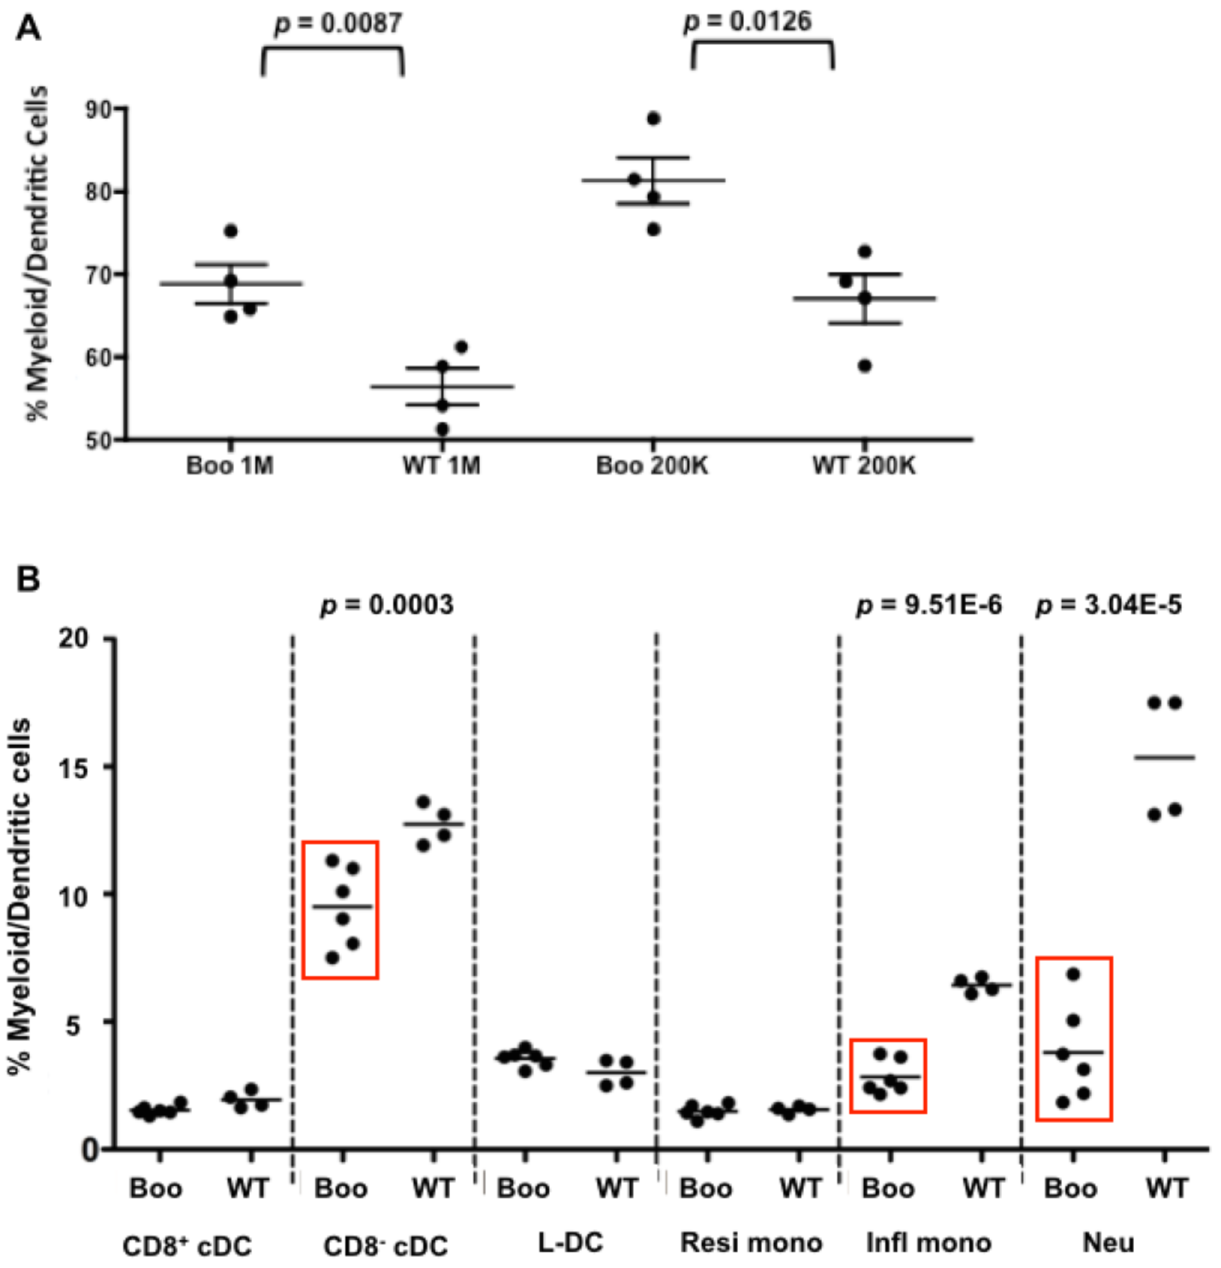
Fig 6. Analysis of splenic myeloid and DC subsets in booreana versus WT mice.(A) Chimeraswerepreparedas described inFig 1 and sacrificedat 52weeks.The totalsplenicdendriticandmyeloidsubsetwas purifiedvia red bloodcelllysis andT/B celldepletion. Cellswerestained withantibodyto detectCD45.2 + cells,andthe populationgatedas CD11b + and/orCD11c + to estimate% dendritic/myeloidcells,respectively. Datarepresentmean ± SE ( n = 4), and p valuesfor statistically significant pairsof datashown. (B) Spleensof adult booreana and WT mice were enrichedfor DCandmyeloidcellsvia redbloodcelllysis andT/B celldepletion. Cellswerethenstainedwithantibodiesto delineatesubsetsof CD8 + cDCs(CD11c hi CD11b - MHCII + CD8 + ), CD8 - cDCs(CD11c hi CD11b lo MHCII + CD8 - ), L-DCs(CD11c lo CD11b hi Ly6C - Ly6G - ), resident monocytes (resimono:CD11b hi CD11c lo/- Ly6C + Ly6G - ), inflammatory monocytes (infl mono:CD11b hi CD11c - Ly6C hi Ly6G - ), andneutrophils (neu: CD11b hi CD11c - Ly6C + Ly6G + ). The proportional representation of eachsubsetwascalculatedrelativeto the totaldendriticandmyeloidpopulation inspleen(i.e. CD11b + and/orCD11c + cells,respectively). Data(mean)areshownfor boo/boo ( n = 3) andWT ( n = 4) mice. Statisticallysignificant findings( p (cid:20) 0.01)areboxedand p valuesare shown.